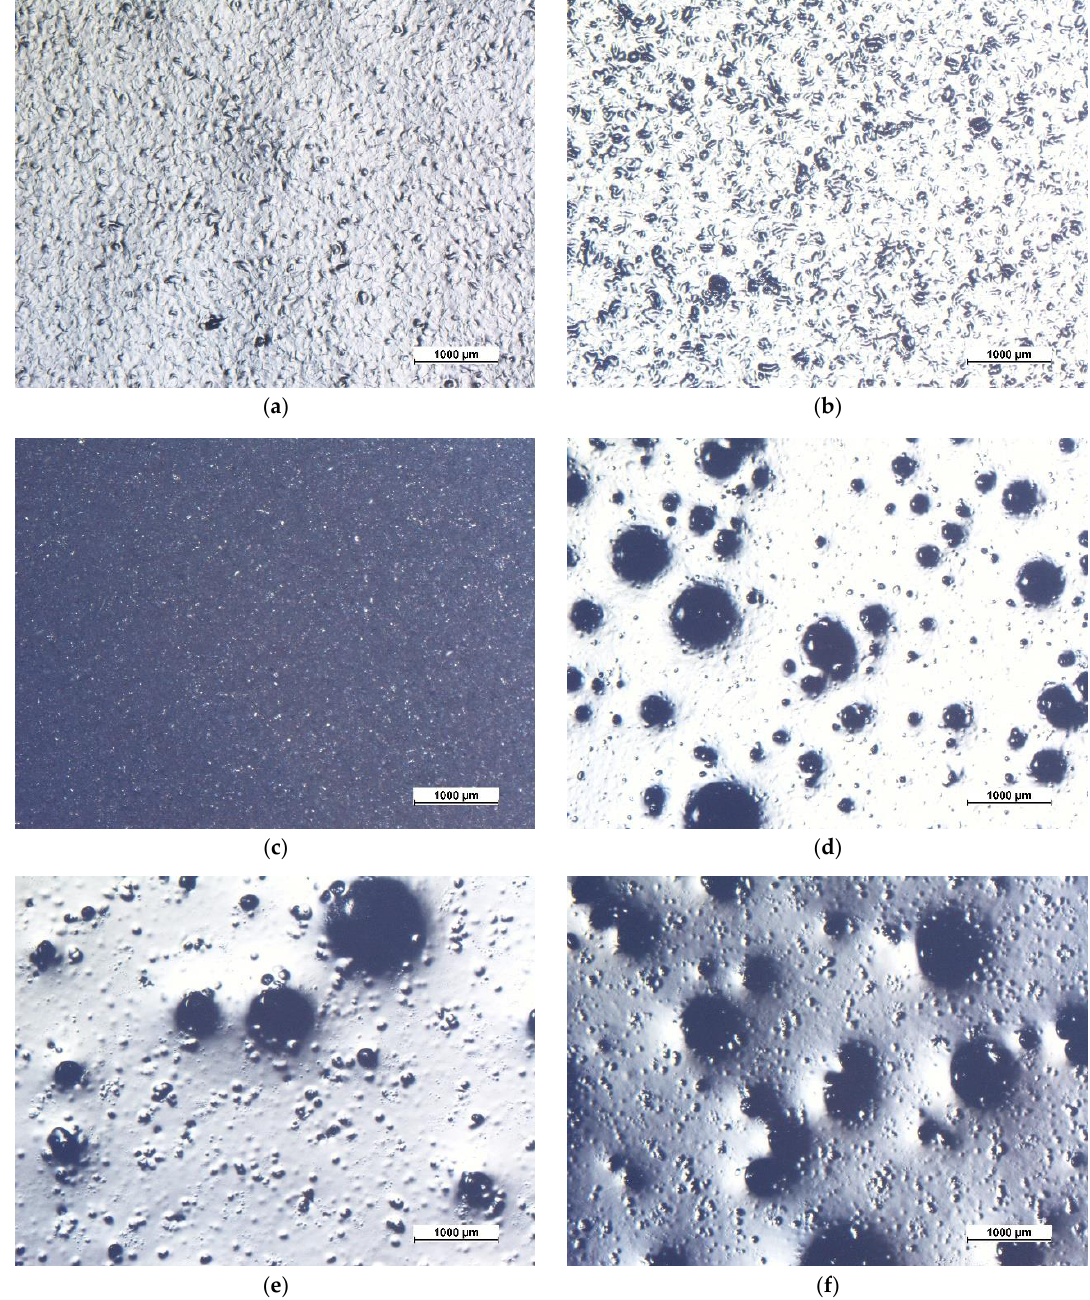
Figure 2. Optical stereomicroscope micrographs of the surface of sample C ( a ), sample CfGO ( b ), sample S ( c ), sample SG ( d ), sample C-SG ( e ) and sample CfGO-SG ( f ), respectively.